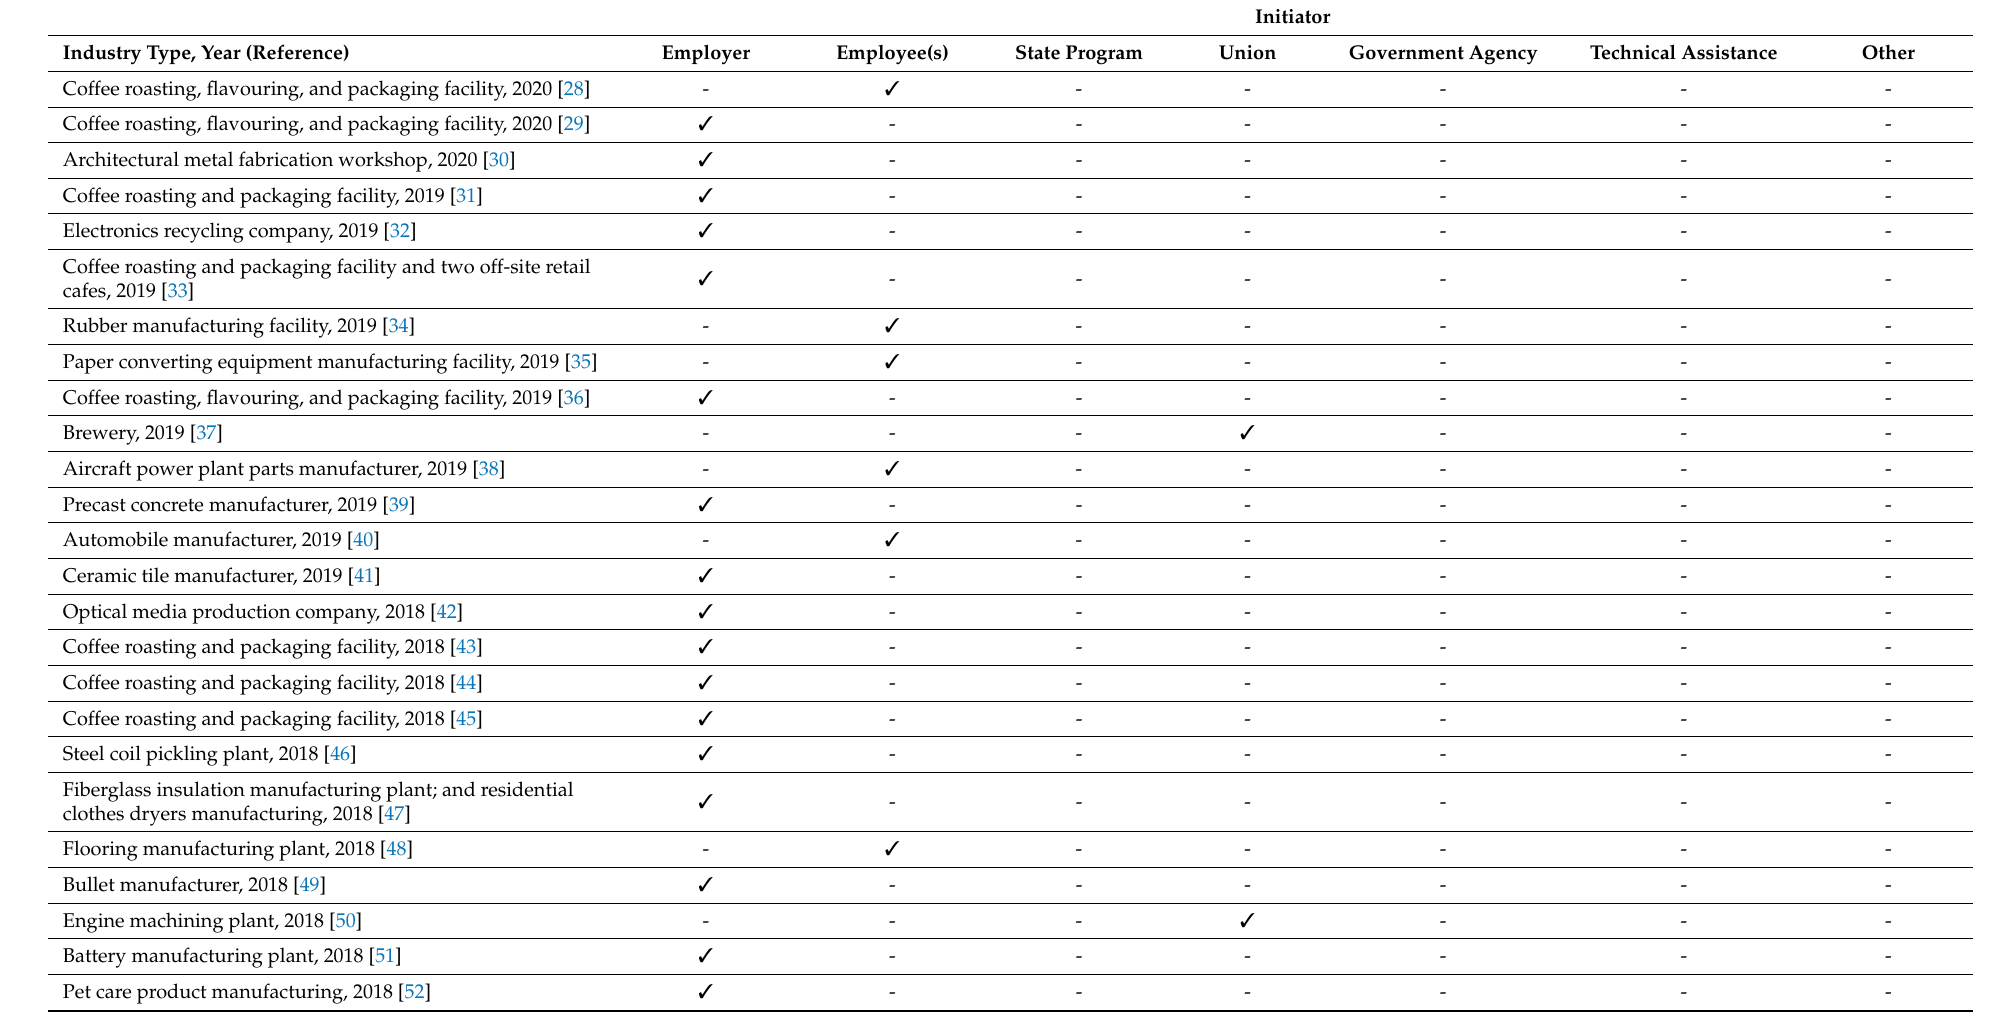
Table 1. Qualitative overview of initiators of NIOSH–HHE investigations